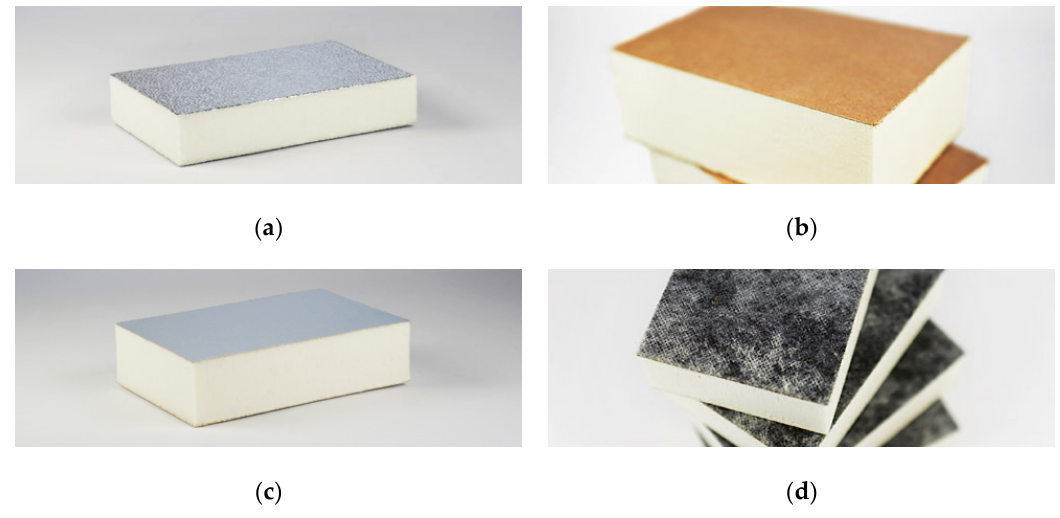
Figure 1. Types of polyisocyanurate (PIR) facings: ( a ) aluminum foil; ( b ) composite paper foil; ( c ) multilayer aluminized facing; ( d ) bitumen facing [14].